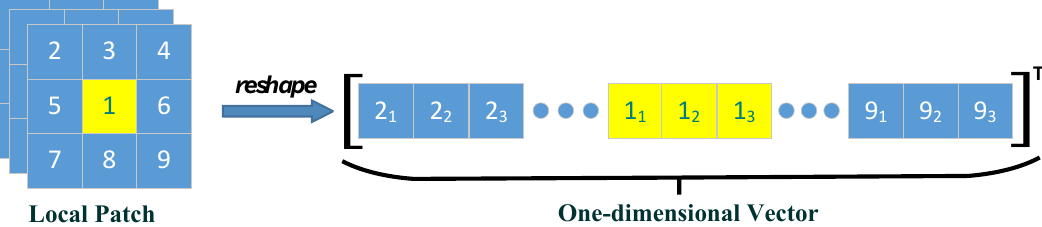
Figure 1. Schematic illustration of the patch-based spatial–spectral constrain. Pixel 1 is the center, and pixel 2 ∼ 9 are the neighborhood pixels. The bottom-right number of each pixel is its corresponding spectral band number. As there are 3 bands and the patch size is 3 × 3, the size of the reshaped one-dimensional vector is ( 3 × 3 × 3 ) × 1 = 27 × 1. According to this rule, supposing that the original HSI cube is rows × columns × nbands and that the patch is n × n , then the 2-D patch-based matrix is [ nbands × n × n ] × [ rows × columns ]